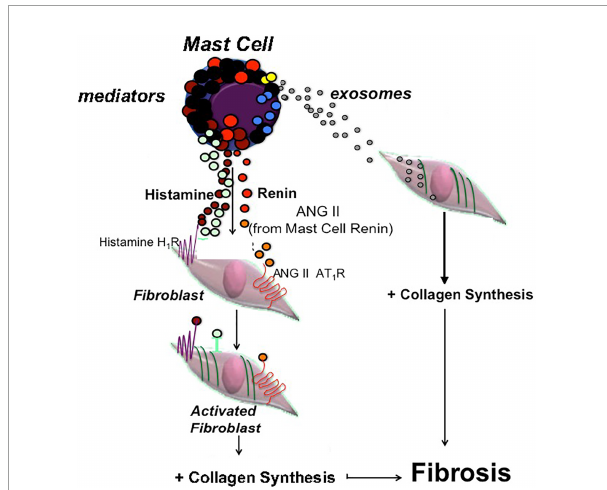
FIGURE6 Cartoon depicting two parallel pathways in mast cells leading to fibroblast activation and excess collagen production. One pathway depicts classic mast cell degranulation with release of pro-fibrotic mediators like histamine and renin (ANG II), acting on the resident receptors on fibroblasts that activate the collagen synthesis pathway. The other pathway is the newly identified exosome pathway where shed exosomes are taken up in the cytosol of fibroblasts leading to proline hydroxylation and increased collagen